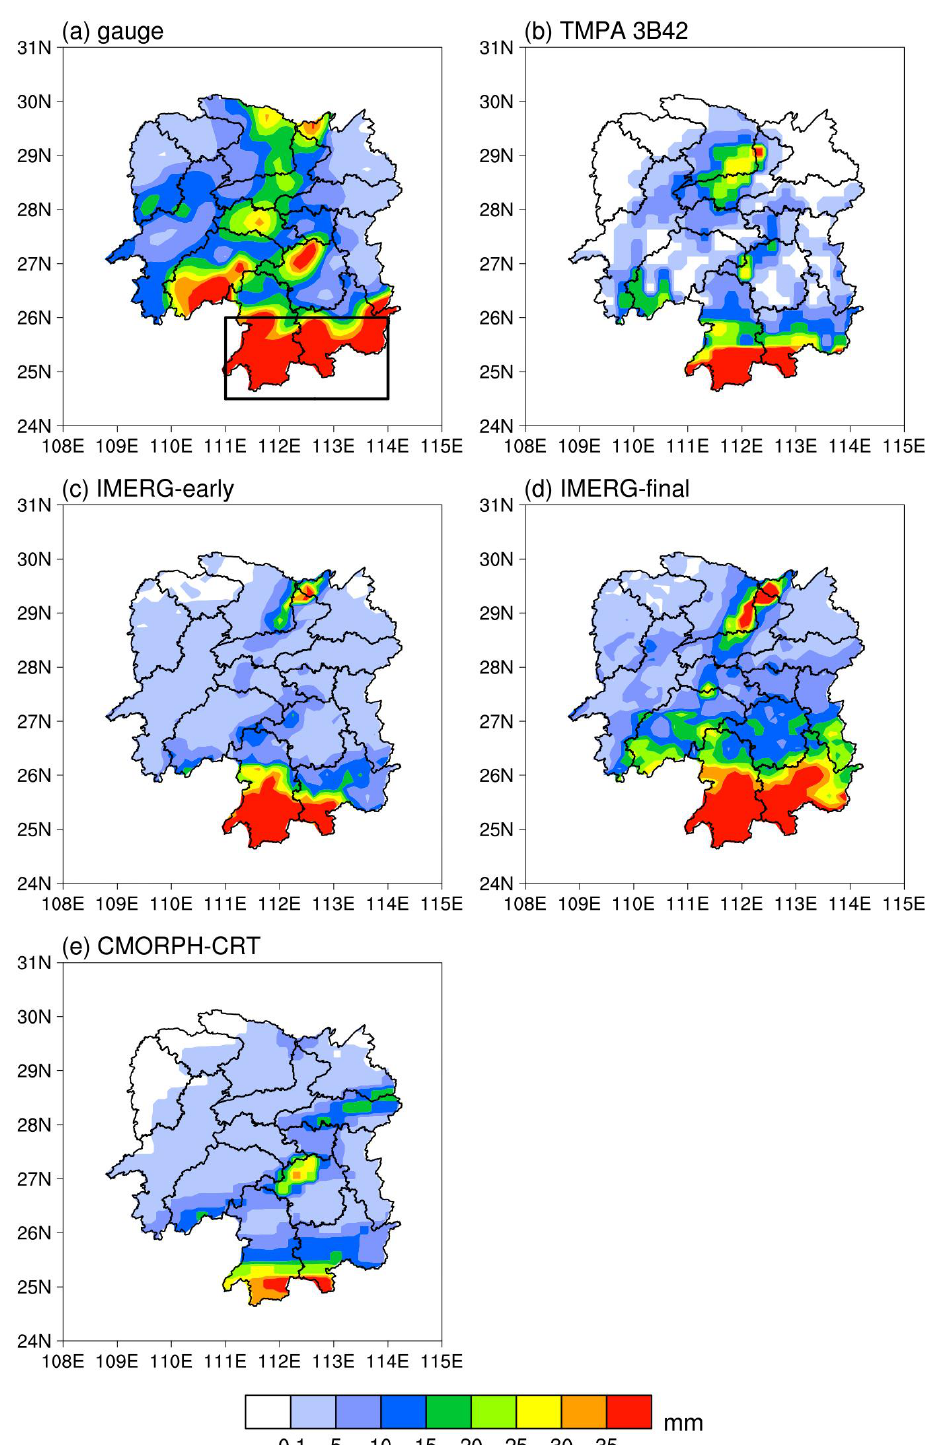
Figure 8. Accumulated precipitation during Typhoon Bailu between 25 August 2019 at 00:00 and 27 August 2019 at 00:00 (UTC).